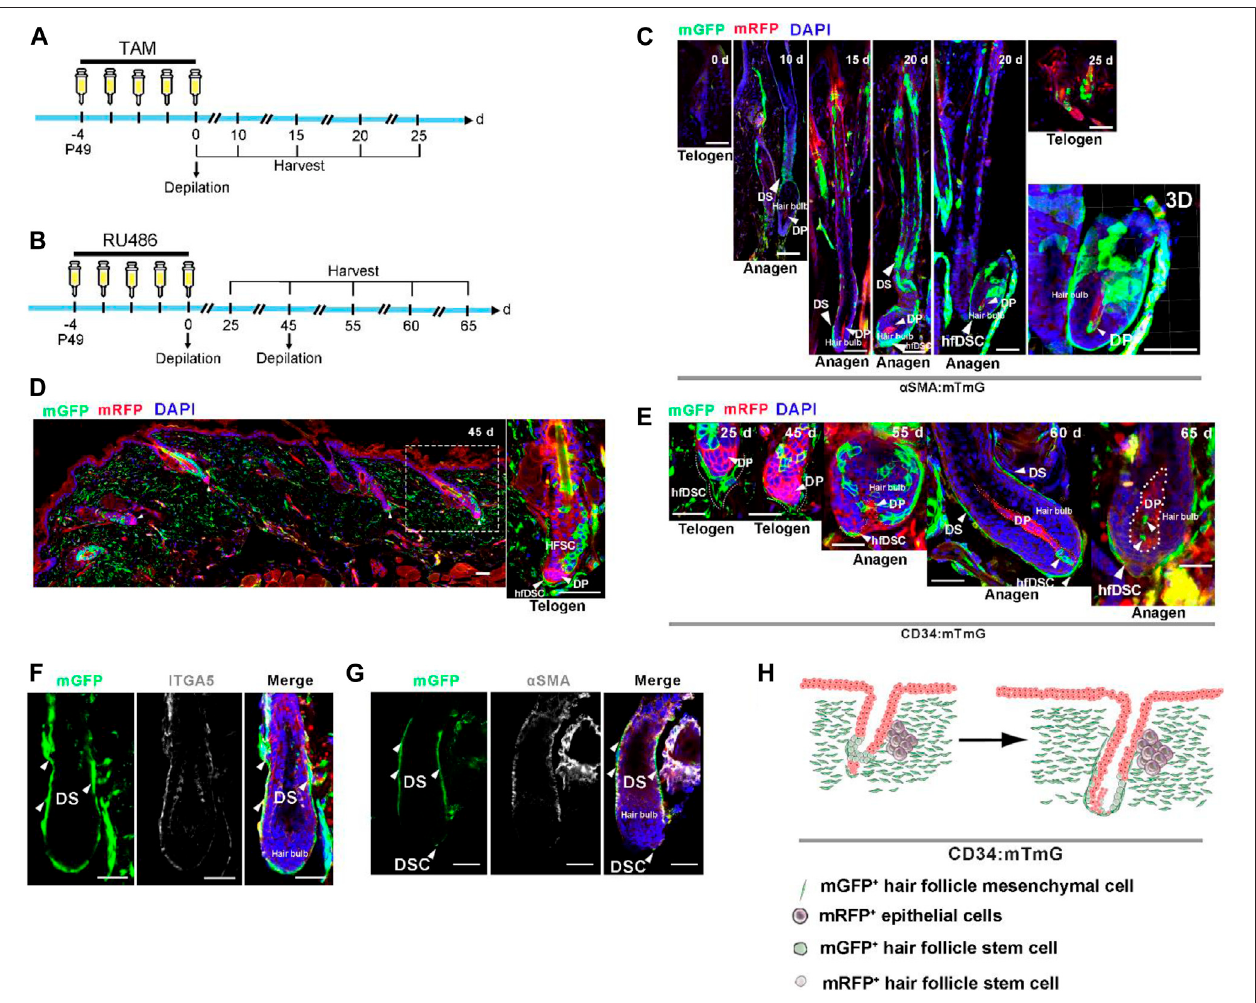
FIGURE 2 | CD34 + hfDSC progeny repopulate DS and DP cells during an ongoing hair cycle. (A) Outline of lineage-tracing strategy in α SMA:mTmG mice. (B) ExperimentaldesignshowingfatemappingassessmentofCD34 + hfDSCslabeledatP49-53andharvestedatdifferentstagesofthehaircycle. (C) TypicalimagesofHFs in α SMA:mTmG mice at different stages. Confocal reconstructions of an anagen HF showed that α SMA + hfDSCs supplemented DP cells (right-most panel). (D) Representative telogen HFs 45 days post fi rst depilation showing the distribution ofmGFP fl uorescent protein in hfDSCs (left panel). Ahigher-magni fi cation viewof theleftpanel(rightpanel). (E) FateofCD34-lineagecells(green)atdifferentstagesofthehaircycle.Dottedlines:approximatelocationofDP. (F) ITGA5immunostainingof an anagen HF from CD34:mTmG mice. (G) An anagen HF from CD34:mTmG mice immunostained for α SMA. α SMA, alpha smooth muscle actin. (H) Schematic summary of the fate of CD34-lineage cells (green) during the second depilation-induced hair cycle. Scale bars, 50 μ m.